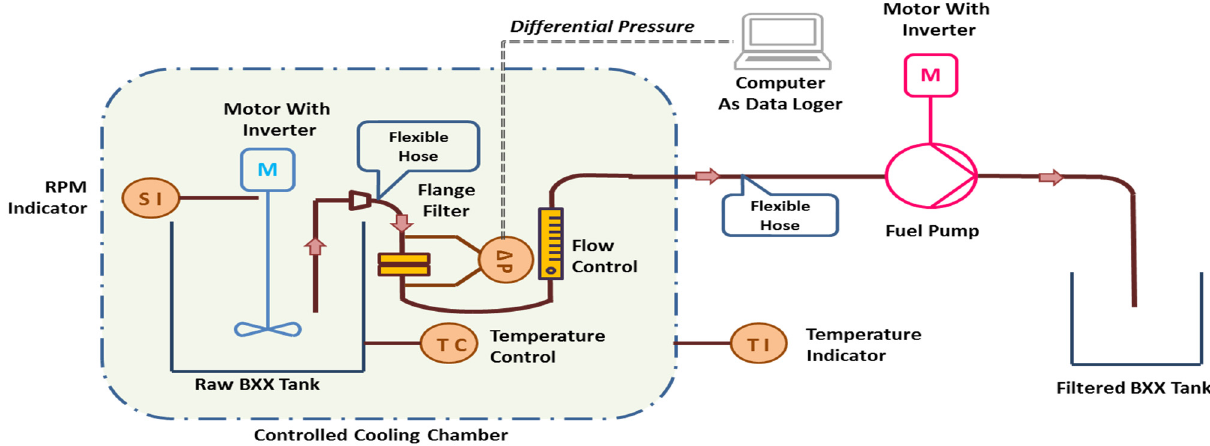
Figure 1. Modified FBT system.